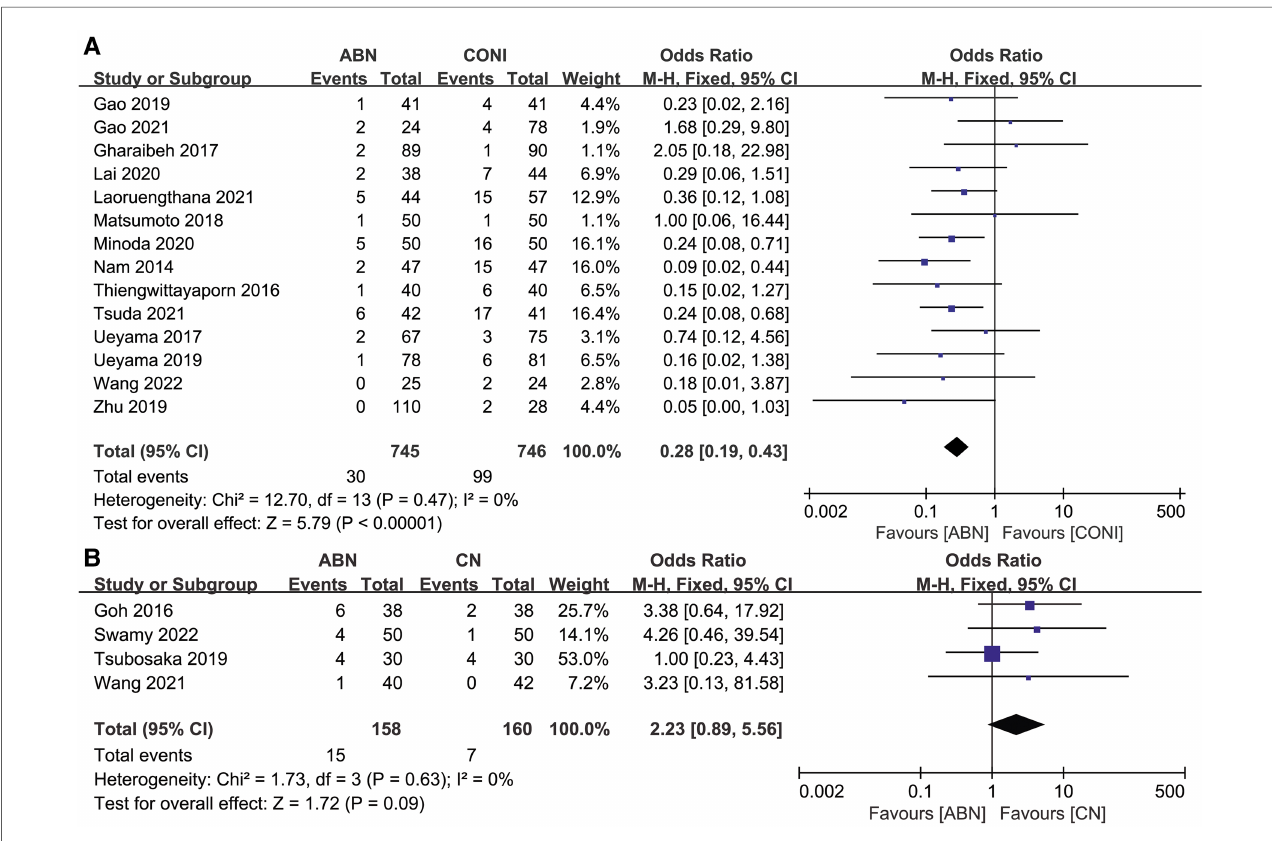
FIGURE 8 Forest plot of CTA outliers. ( A ) Accelerometer-based navigation (ABN) system vs. conventional instrumentation (CONI); ( B ) ABN system vs. computer navigation (CN)